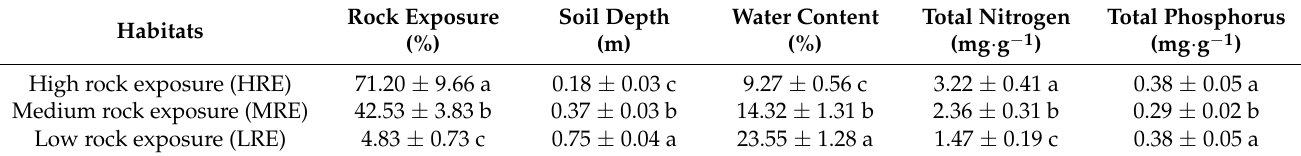
Table 1. Rock exposure and soil characteristics of three habitats in Phyllostachys glauca